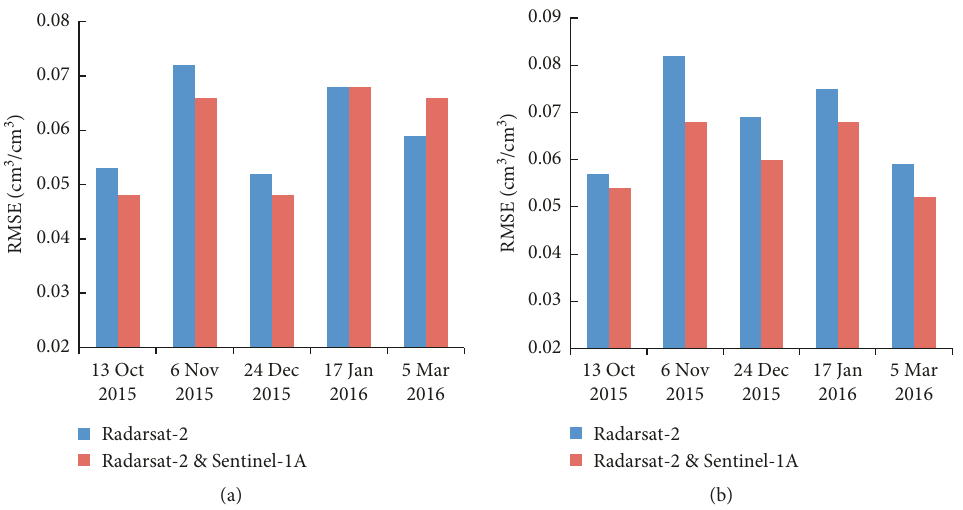
Figure 9: Comparison of soil moisture retrieval between the Alpha model and the developed method. (a) JiuLong experimental dataset. (b) WanNian experimental dataset.